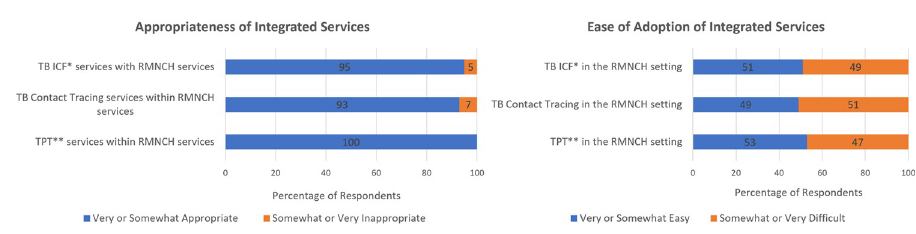
Fig 2. Health care worker perspective on the appropriateness and ease of TB integrated services in reproductive, maternal, neonatal and child health services at four health facilities in Eswatini, 2017 (N = 43). � ICF = Intensified Case Finding, �� TPT = Tuberculosis Preventive